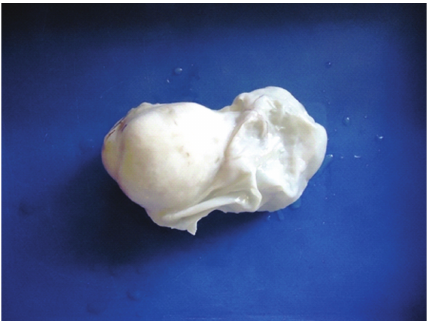
Figure 3: Histology of solid part: spindle cells arranged in sheets/ fascicles. (H&E × 400).